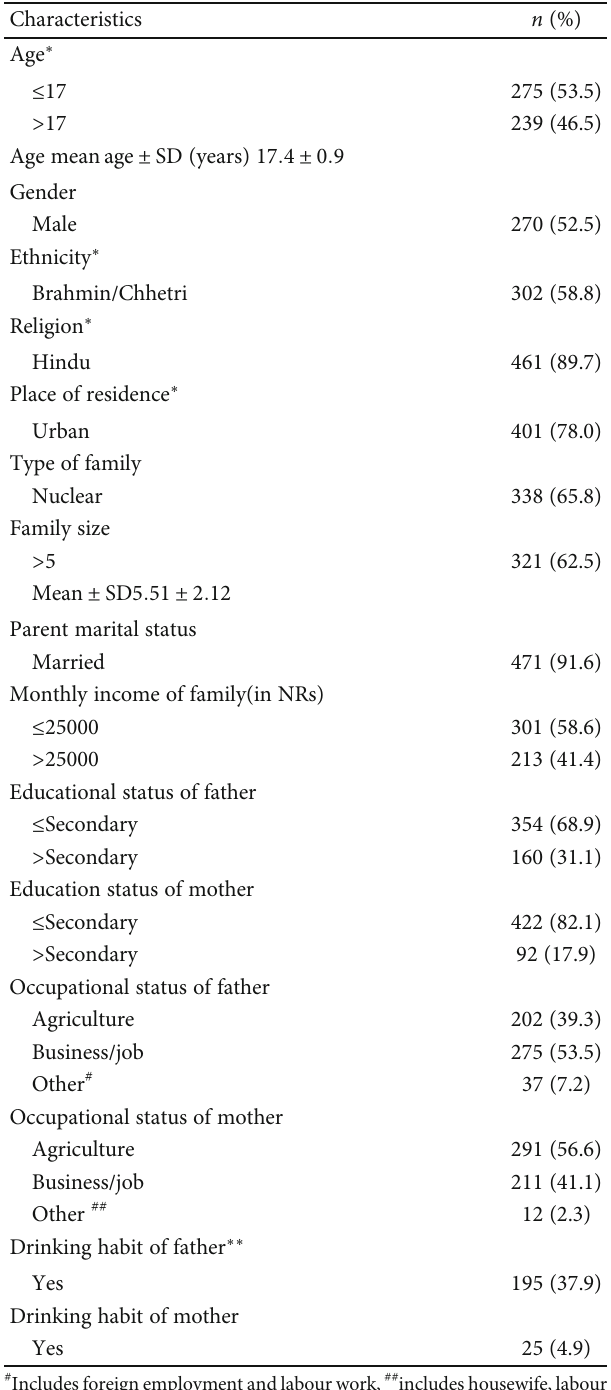
Table 1: Demographic and economic characteristics of respondents and their family ( n = 514